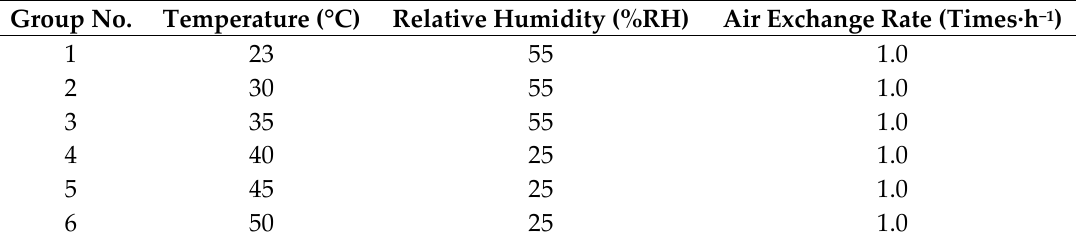
Table 1. The table of Experimental